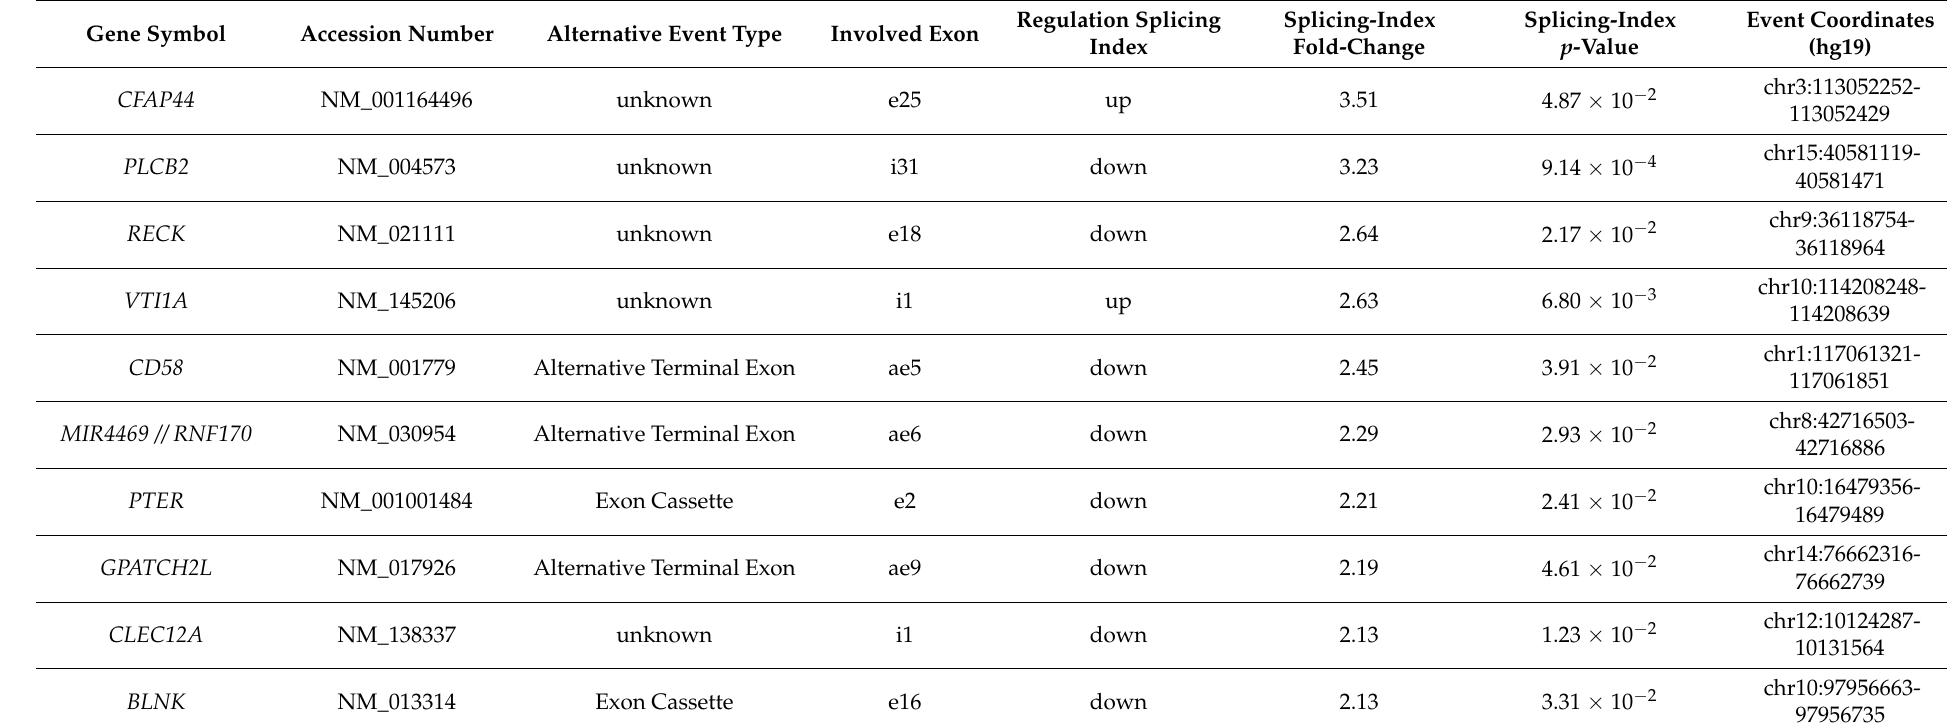
Table 3. 10 differentially regulated AS events in CAD PBMCs involving different 10